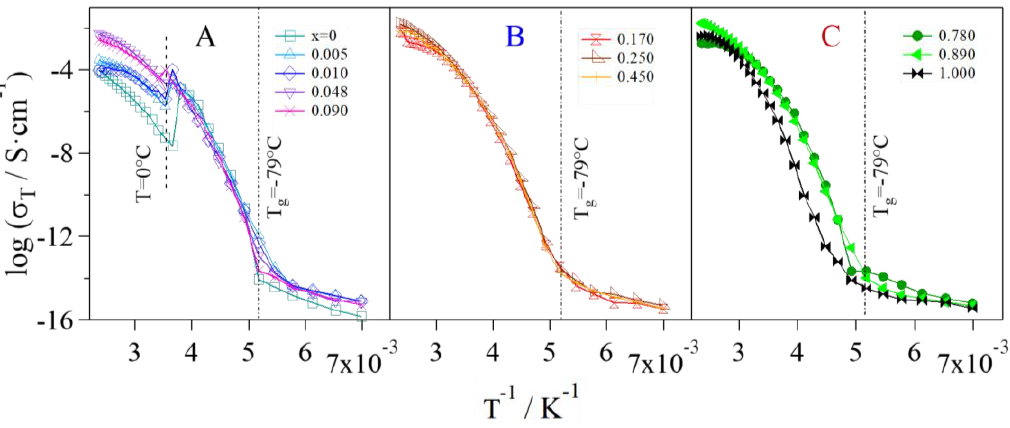
Figure 10. Log σ T vs T −1 curves for the various groups of GlyLi x samples. Group A: x ≤ 0.090; Group B: 0.170 ≤ x ≤ 0.450; Group C: 0.780 ≤ x ≤ 1.000.